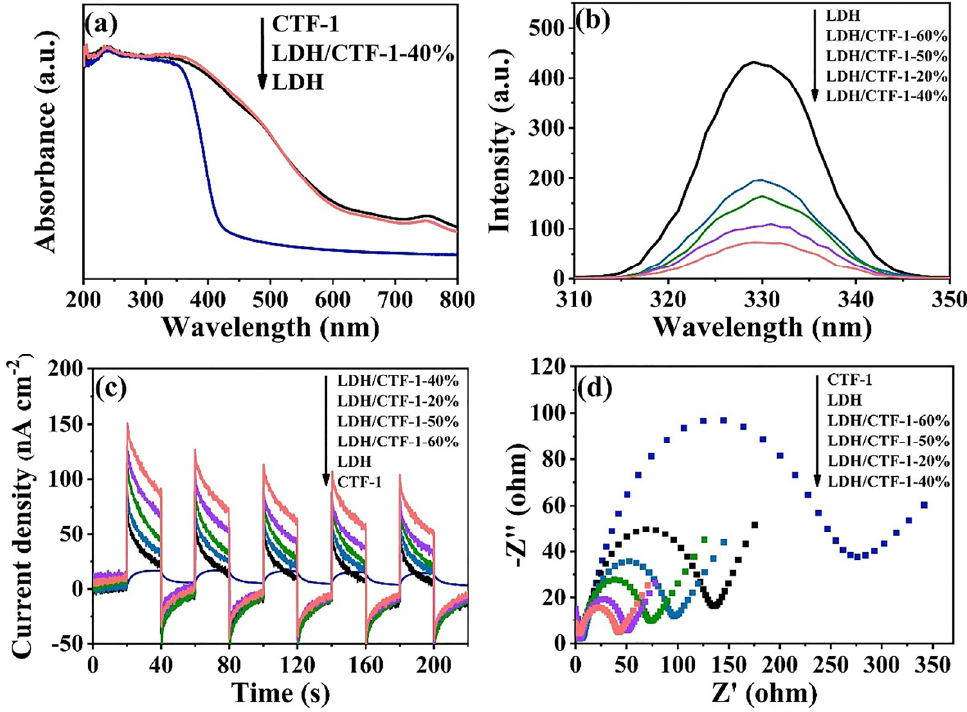
Figure 6. ( a ) UV-vis DRS; ( b ) PL spectra; ( c ) photocurrent responses; ( d ) EIS Nyquist plots for the pure LDH, CTF-1, and the LDH/CTF-1